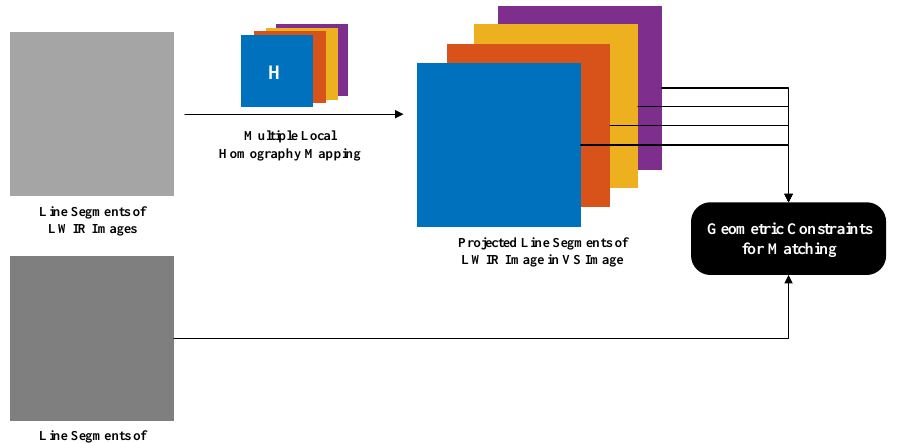
Figure 4. Illustration of multiple local homographies for matching line segments in IR and VS